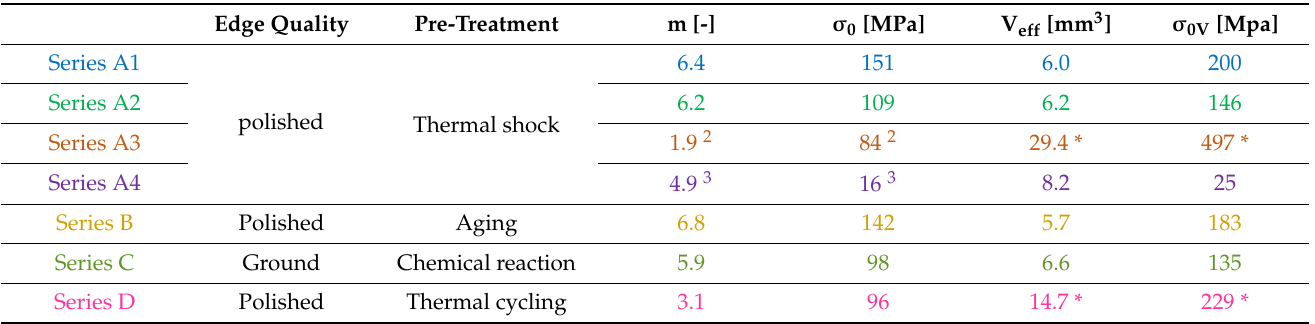
Table 5. Weibull parameters, effective volume, and resulting normalized strength of pre-treated brittle ring